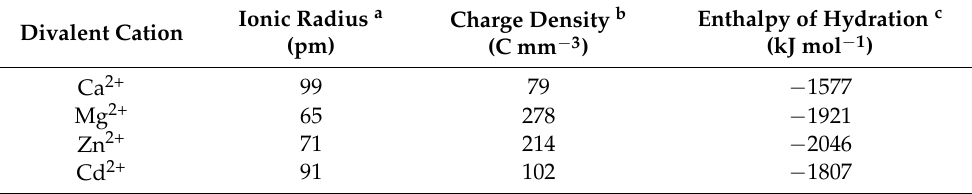
Table 2. Physical characteristics of divalent cations implicated in permeation through ion channels. Ionic Radius a Enthalpy of Hydration Charge Density b Divalent Cation (pm) (C mm − 3 )